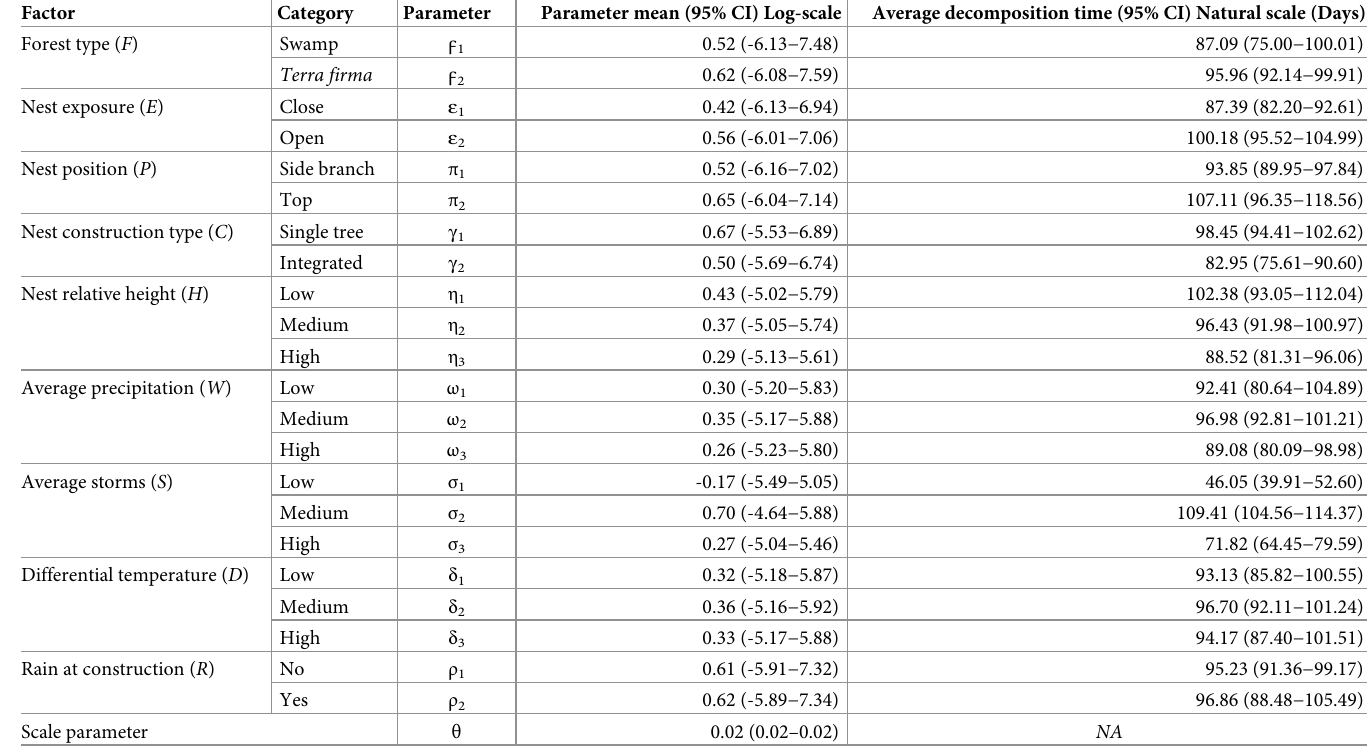
Table 3. Factors influencing nest decomposition time: Results of the survival model.